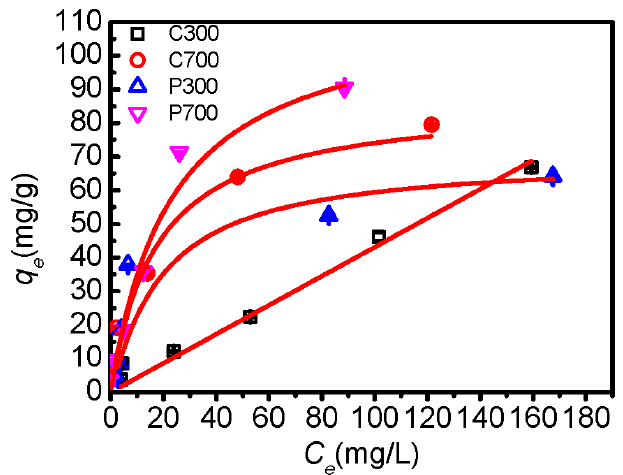
Figure 4. Adsorption isotherms for DBSA on crop straw and poplar leaf biochars. The bars are the standard errors. The lines represent linear and Langmuir equations fitting. Table 7. Electron spin resonance (ESR) parameters for biochars and its products of interaction with DBSA.